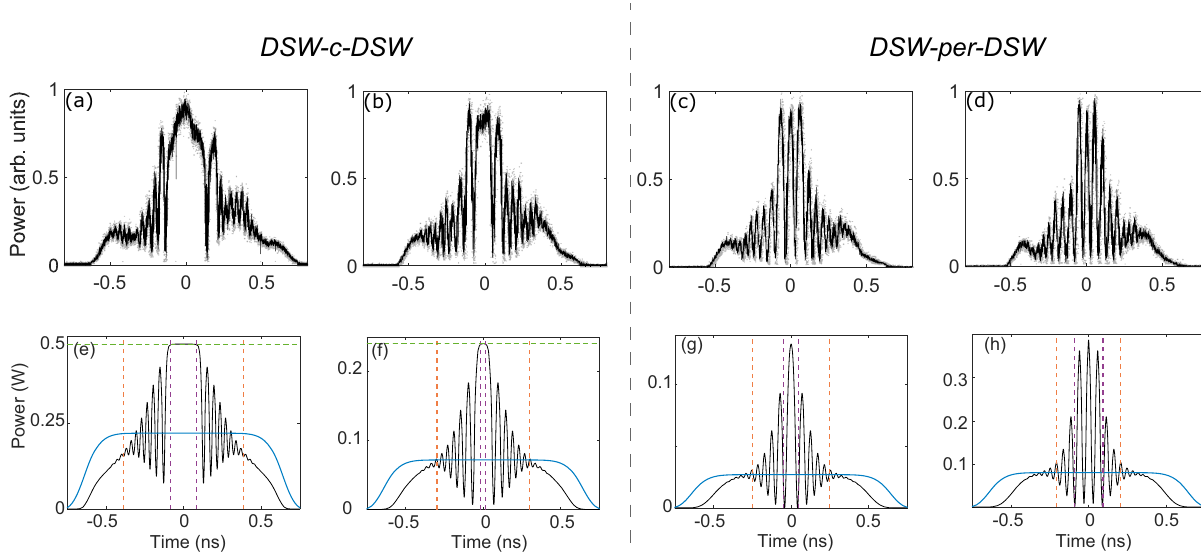
Fig. 6 Pushing piston experiment. Shock formation: DSW-c-DSW ( a , b ) and their phase transition to DSW-per-DSW ( c , d ), observed for Δ f 0 = 9.4 GHz, and power: ( a ) P 0 = 220 mW ( u 0 = 0.95); ( b ) P 0 = 72 mW ( u 0 = 1.66); ( c ) P 0 = 27 mW ( u 0 = 2.71); ( d ) P 0 = 8 mW ( u 0 = 4.97). e – h Output pro fi les obtained from numerical simulation of the NLSE (1). Vertical dashed lines arise from modulation theory: linear DSW edges (orange) and soliton edges in ( a , b ) or periodic wave edges in ( c , d ) (magenta). In ( e , f ) the horizontal green line stands for ρ i P 0 , with ρ i from Eq.